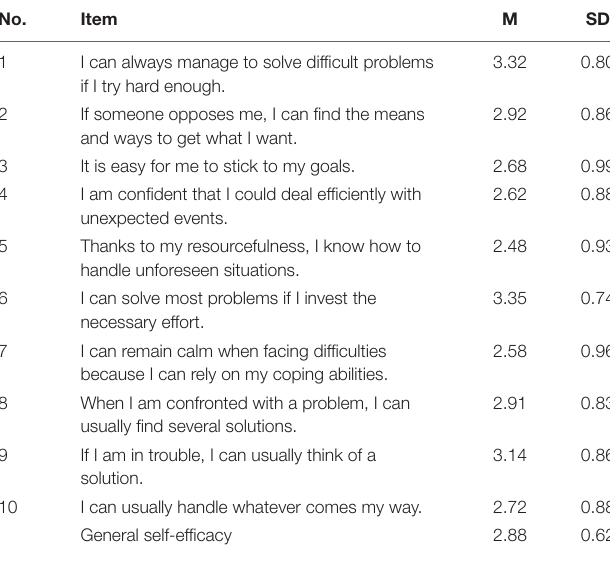
TABLE 1 | Distribution of answers of the general self-efficacy scale ( N =